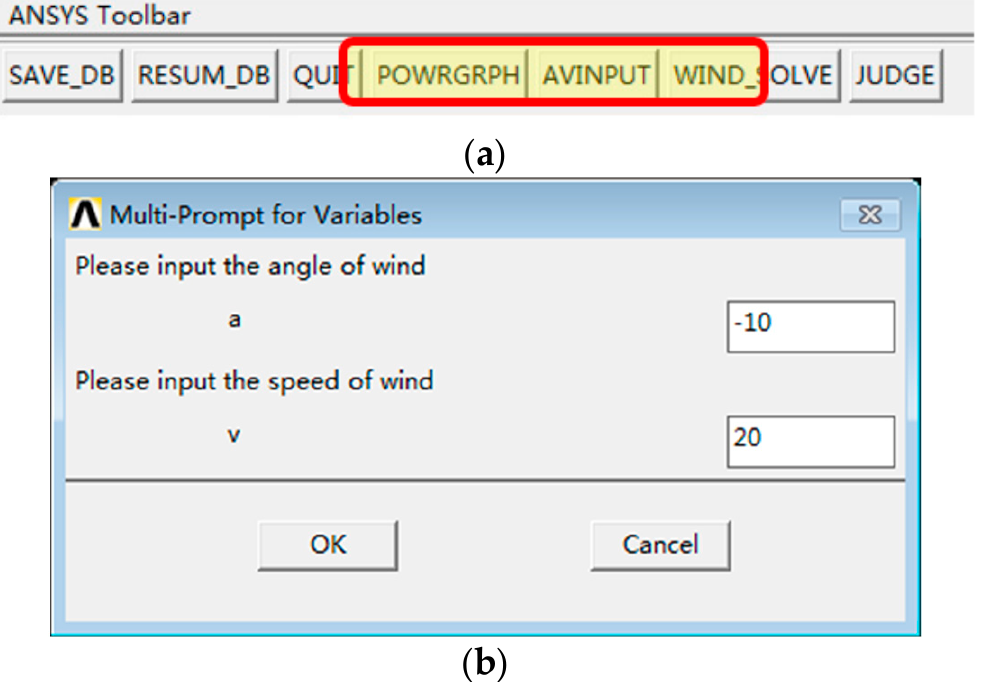
Figure 8. ANSYS solution process diagram. ( a ) User Toolbar; ( b ) Parameter input dialog box.